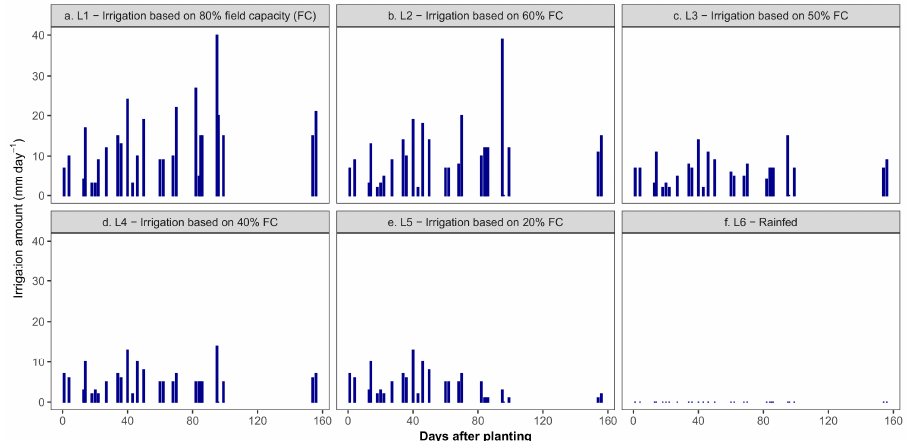
Figure 4. Detailed irrigation schedule for the different treatments during the Guinea grass ( Mega ‐ thyrsus maximus cv. Agrosavia sabanera) second growing season (from 17 December 2021 to 4 June